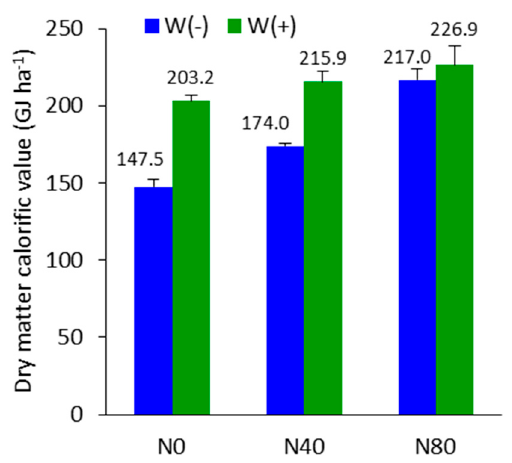
Figure 3. Calorific value of dry cup plant weight.